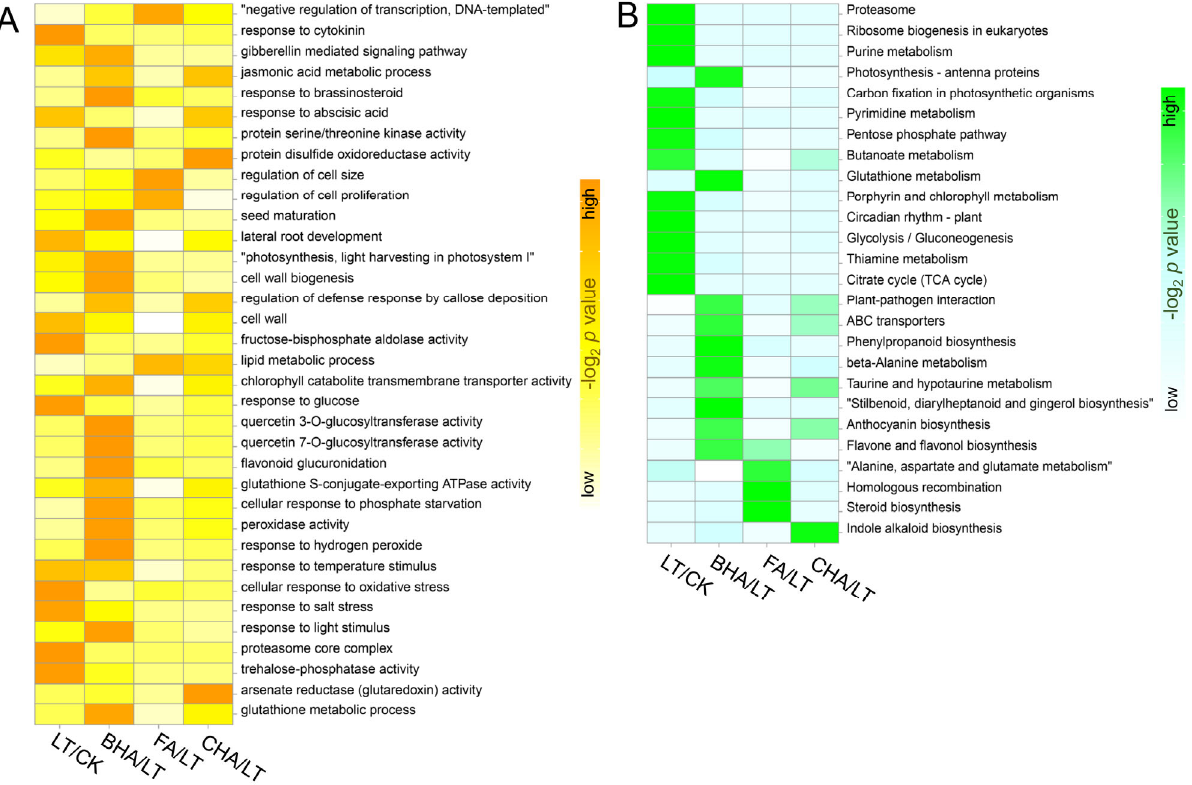
Figure 3. GO ( A ) and KEGG ( B ) pathway analyses. LT, 5 ◦ C. CHA, 5 ◦ C + 0.05% coal-based humic acid. FA, 5 ◦ C+ 0.05% fulvic acid. BHA, 5 ◦ C + 0.05% biochemical humic acid.